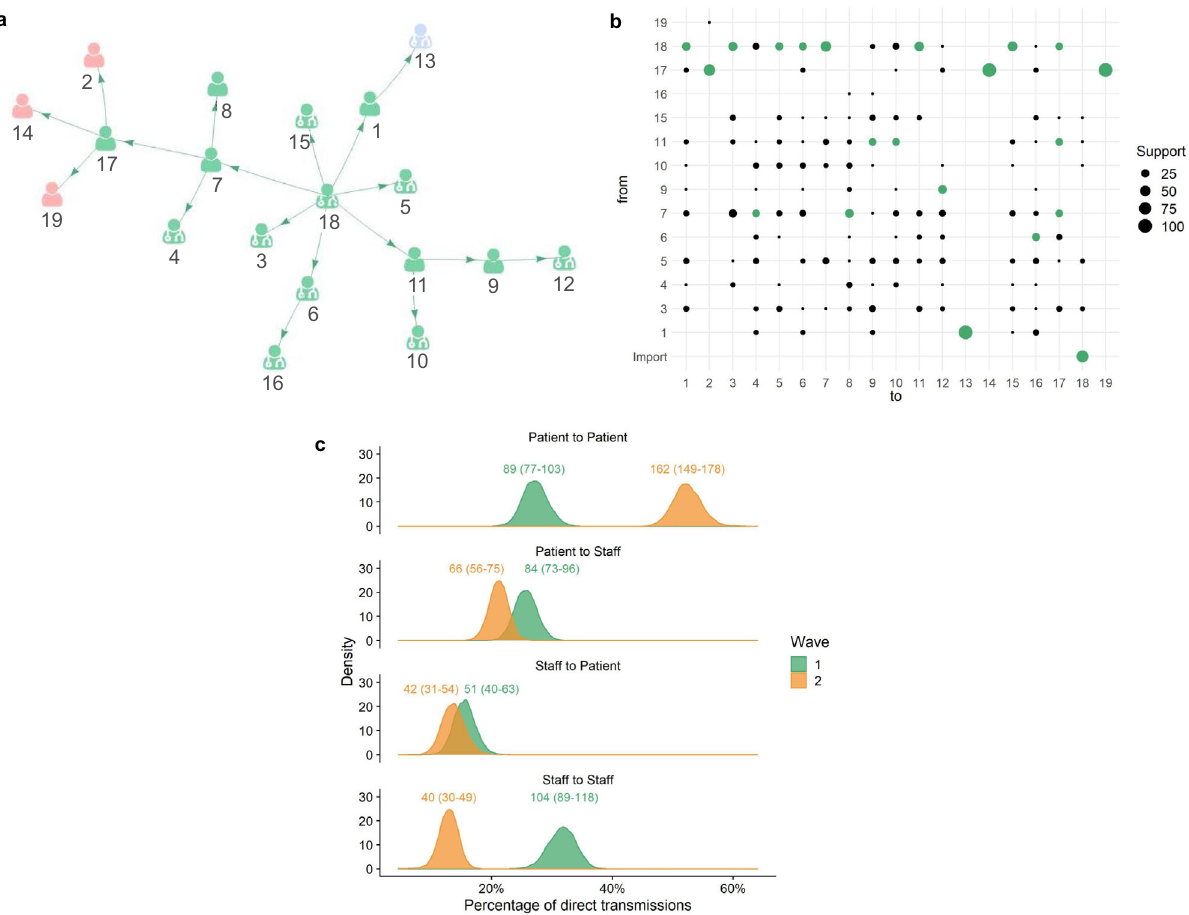
Fig. 2 Within-hospital transmission chains and estimated infections within and between patients and healthcare workers. a An example transmission chain showing transmission between staff (icons with stethoscope) and patients (icons without stethoscope). Icons are labelled with their case identi fi cation number. Each colour represents a separate ward where the infection occurred. b The support (the percentage of networks across all those sampled, where a given infector is assigned to each case) for each potential transmission pair shown in the example network in panel 2a. Numbers on the plot correspond to the case identi fi cation numbers in Fig. 2a and the green circles correspond to the transmission pairs displayed. Import = likely community-acquired infection imported into hospital. From = infector, to = infectee. c Comparison of the percentage of each transmission type between the two waves. The distributions display the percentages throughout the 10,000 plausible networks. The numbers above each distribution are the absolute numbers of each transmission pair with 95% credible intervals shown within the